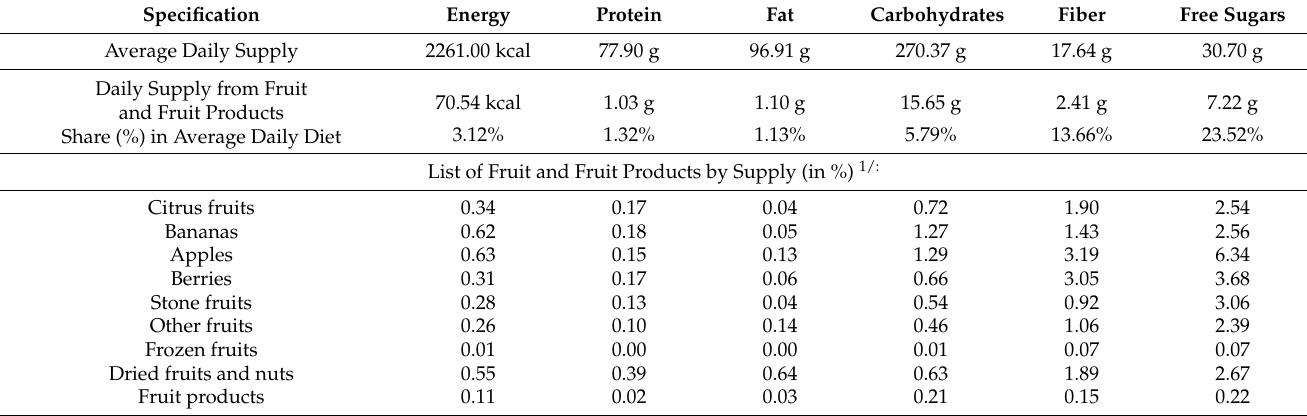
Table 1. Supply of energy, macronutrients and dietary fiber from fruit and fruit